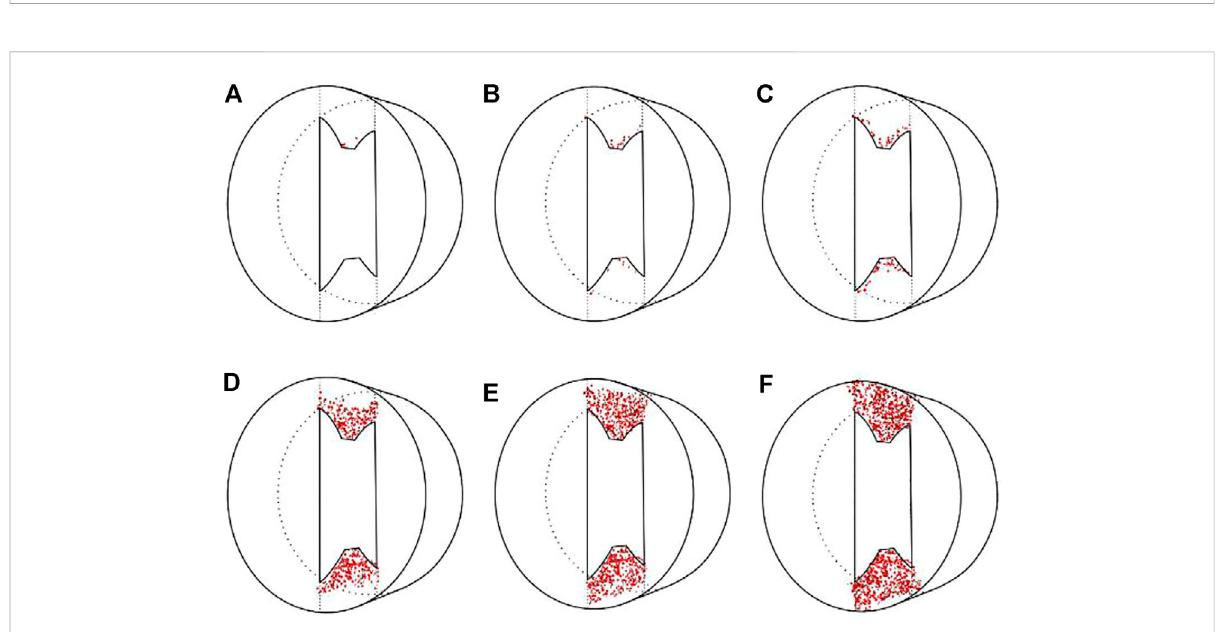
FIGURE 9 3-D numerical particle-based discrete element method progressive fracture process of the ISRM-suggested CCNBD testing specimens at different failure stages (Wang et al.,